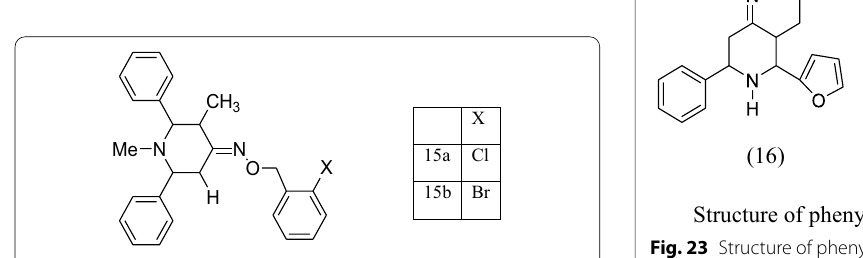
Fig. 21 Structure of nojirimycin